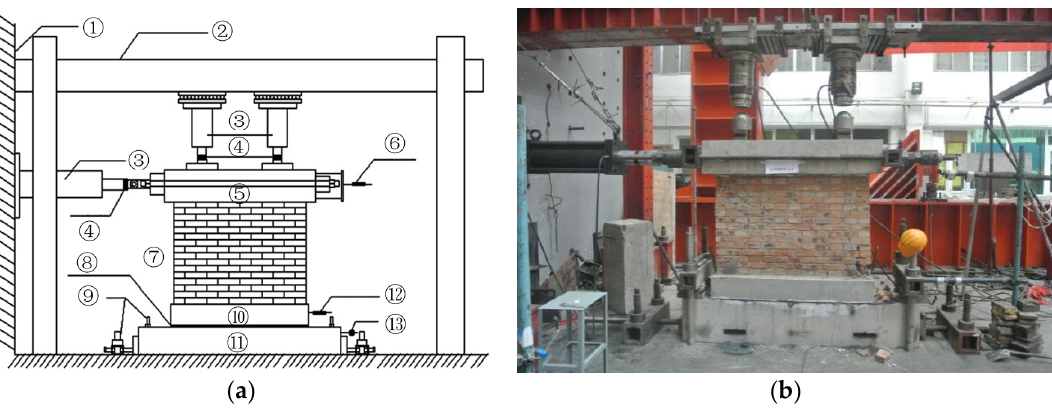
Figure 6. Equipment and measurement: ( a ) loading devices and indicator arrangement; ( b ) test scene; ( ① ‐ reaction wall; ② ‐ loading frame; ③ ‐ 50t jack; ④ ‐ 50t sensor; ⑤ ‐ loading beam; ⑥ ‐ displacement sensor for loading beam; ⑦ ‐ wall; ⑧ ‐ marble ‐ graphite isolator; ⑨ ‐ anchor block; ⑩ ‐ upper foundation beam; (cid:0) ‐ lower foundation beam; (cid:0) ‐ displacement sensor for upper foundation beam; (cid:0) ‐ dial indicator).